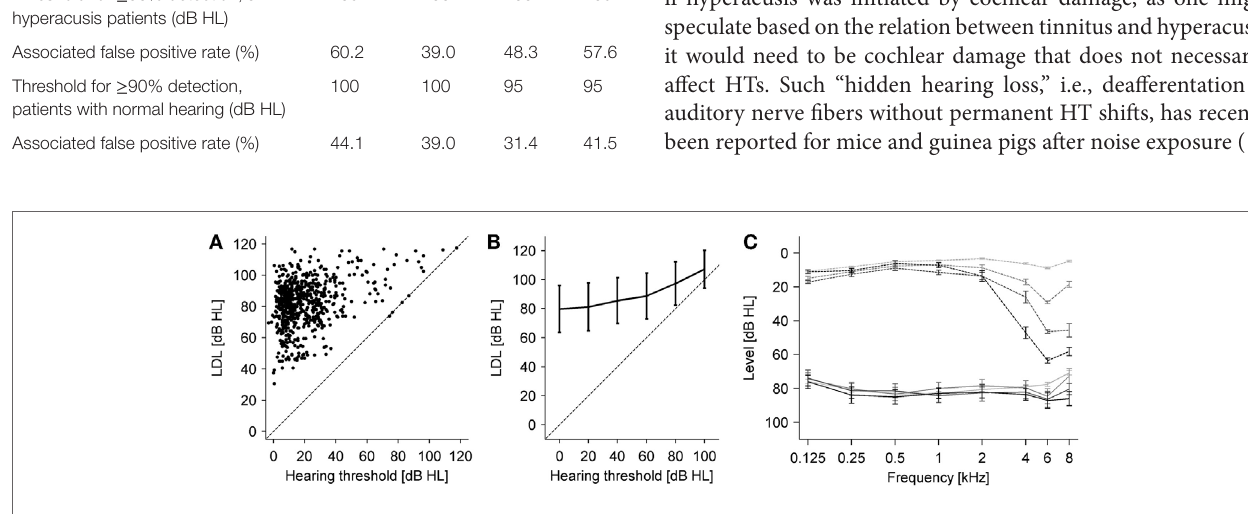
FigUre 4 | relation between lDls and hearing thresholds . (a) Average LDLs (0.5–6 kHz) vs. average hearing thresholds (0.5–6 kHz) for all participants. There was a significant positive correlation between average hearing thresholds and average LDL ( r = 0.36, p < 0.001). (B) Average LDLs for different hearing threshold categories. Hearing thresholds (all patients and all frequencies) were binned using 20 dB bins starting at − 10 dB HL, and the average LDL computed for each bin. The dashed line denotes identity. Error bars are ± 1 SD.